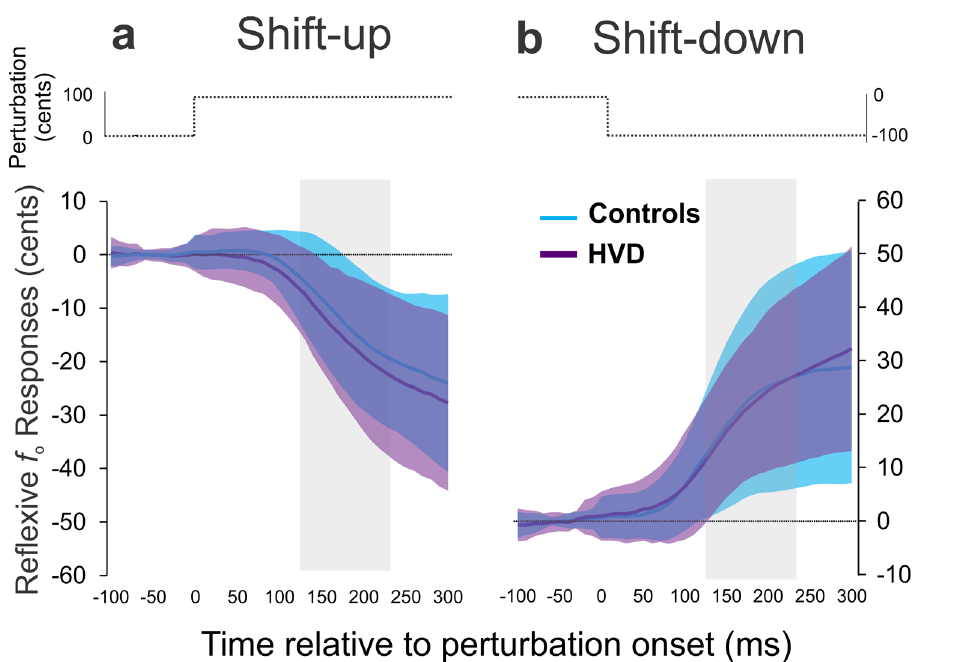
Figure 2. Reflexive responses. Average reflexive responses to voice fundamental frequency ( f o ) in cents are shown for the control group (light blue line) and hyperfunctional voice disorder (HVD) group (dark purple line) for the shift-up (panel a ) and shift-down (panel b ) conditions. The shaded regions in each panel indicates the group means + / − standard deviation for both the control group (light blue shading) and HVD group (dark purple shading). The grey highlighted columns show the time interval used for